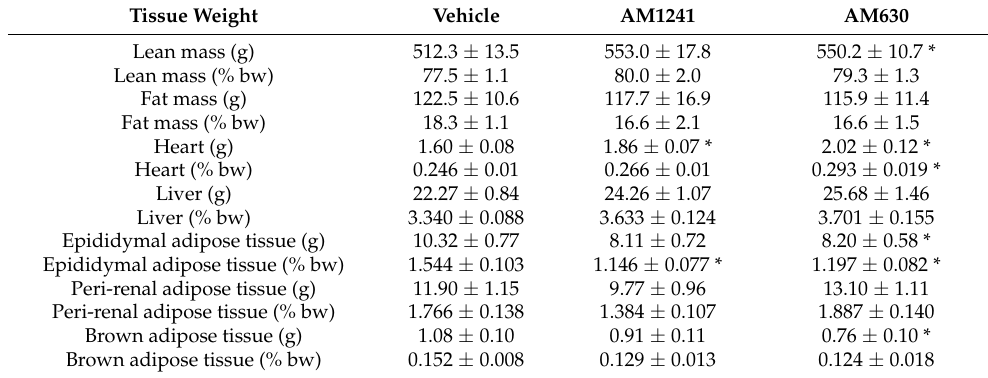
Table 1. The effect of AM1241 or AM630 treatment in DIO on tissue weights in grams (g) and % of total body weight (% bw). DIO rats were injected daily with AM1241 (3 mg/kg of body weight, ip), AM630 (0.3 mg/kg of body weight, ip), or vehicle for six weeks. All results are presented as a mean ± SEM from n = 8–9 (AM1241)-, n = 9–10 (AM630; exception heart n = 5)-, and n = 10 (vehicle; exception heart n = 6)-treated rats on an HFD. Significance * p < 0.05 compared to vehicle.